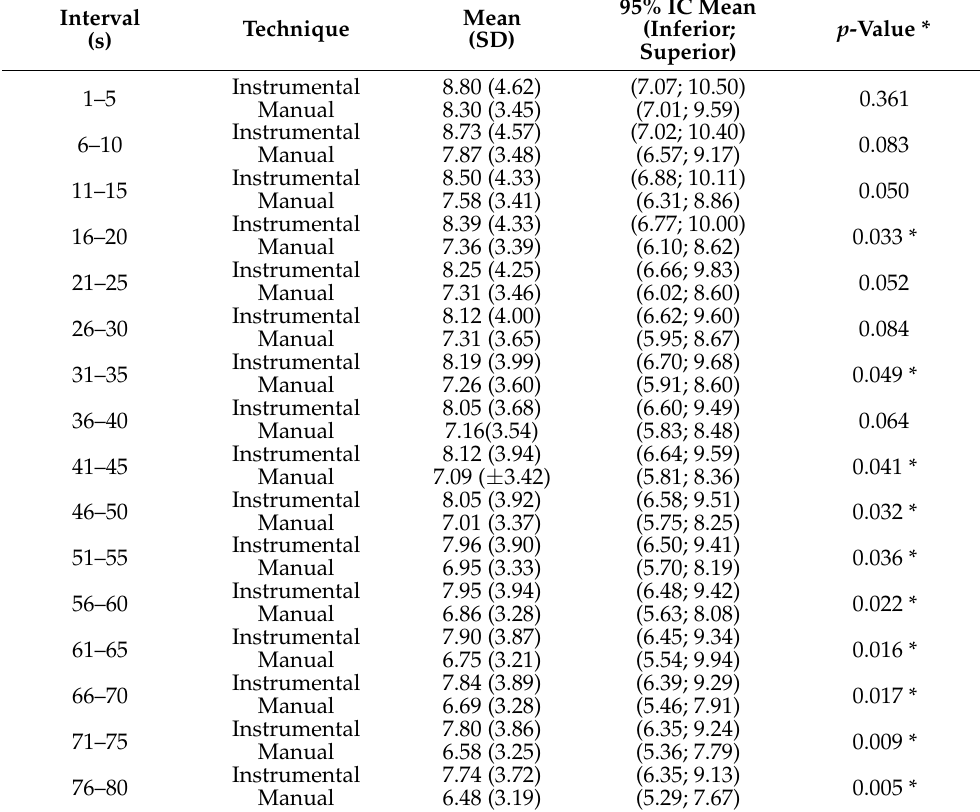
Table 3. Comparison of pressure exerted ( n / cm 2 ) at 5-s interval between groups. Interval